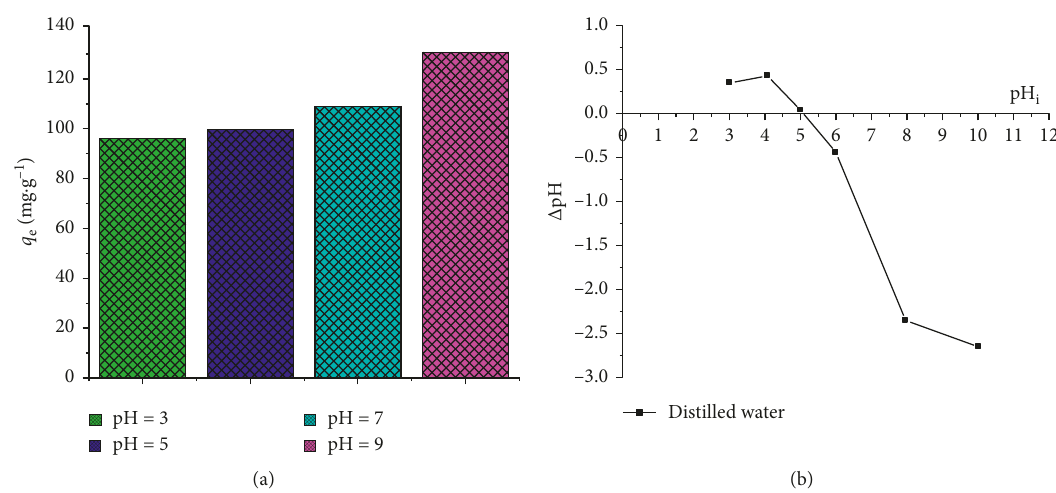
Figure 8: (a) Effect of pH on adsorption capacity; (b) the point of zero charge determined using the pH drift method.